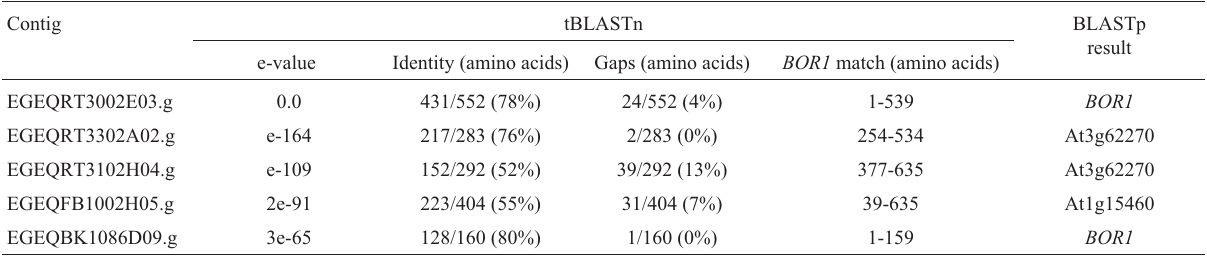
Table1 -EucalyptESTcontigsrelatedto BOR1 intBLASTnsearchshowingtheirrespectivee-value,identity,numberofgapsandsharedregionwiththe query protein. Data were confirmed with translated sequences in BLASTp. Contig tBLASTn